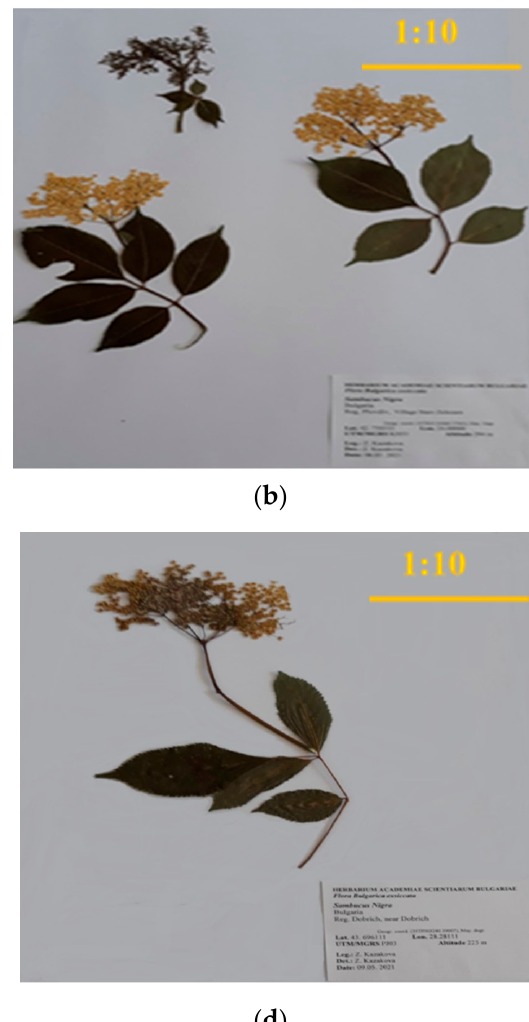
Location Locality